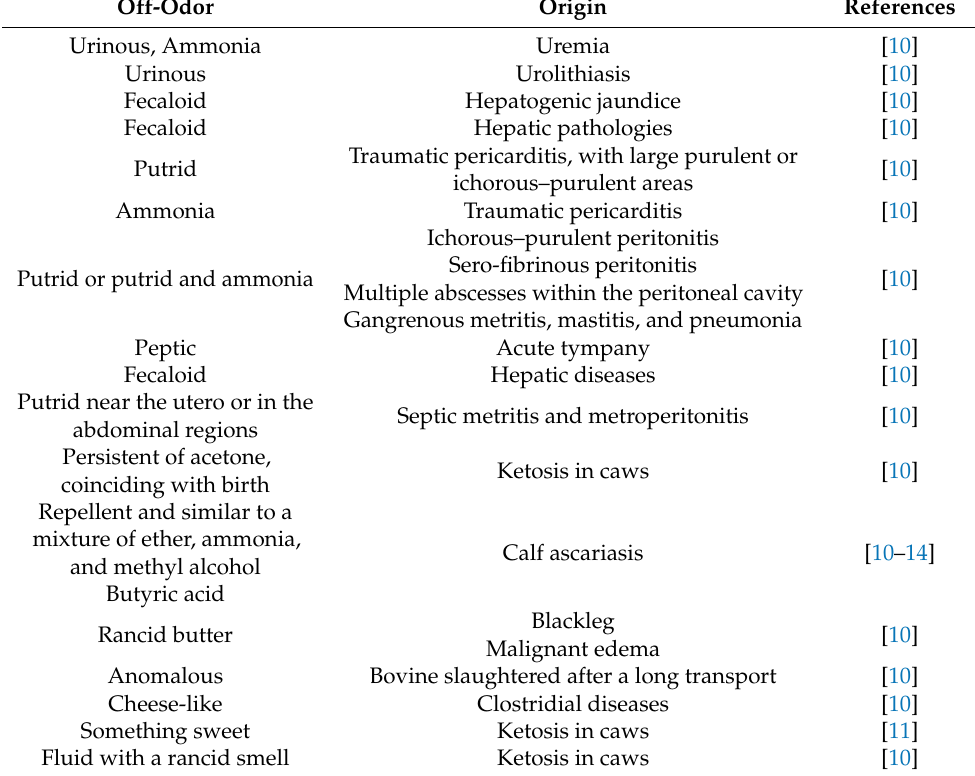
Table 2. Carcasses’ off-odors deriving from